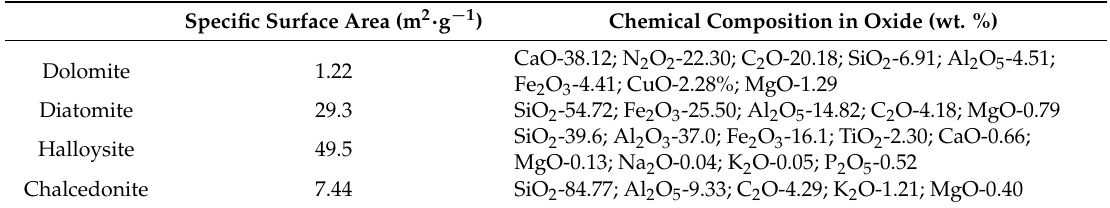
Figure 3. Scanning electron microscope (SEM) micrographs of dolomite ( a ), diatomite ( b ), halloysite ( c ), chalcedonite ( d ). Table 2. Properties of soil